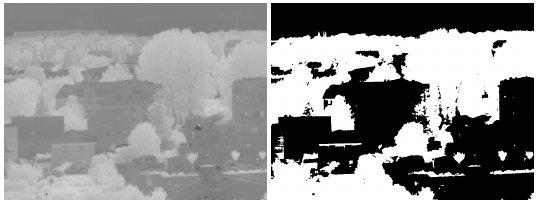
Figure 12. NDVI of an image ROI